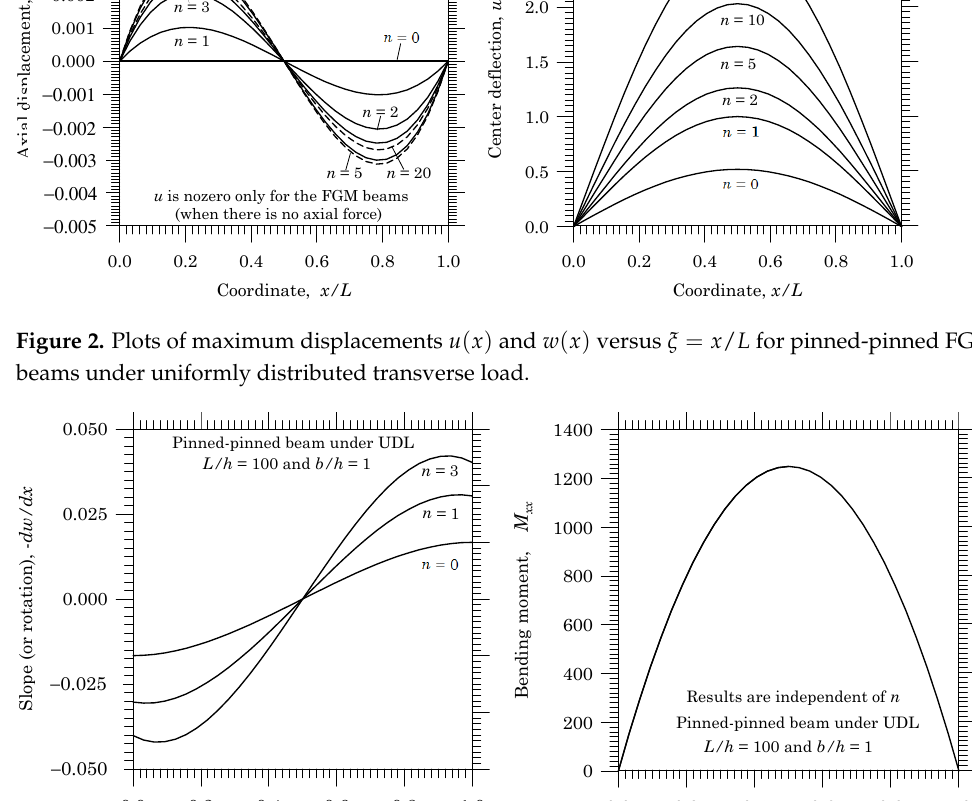
Figure 3. Plots of maximum slope and bending moment − ( dw / dx )( x ) and M xx ( x ) versus ξ = x / L for pinned-pinned FGM beams under uniformly distributed transverse load.